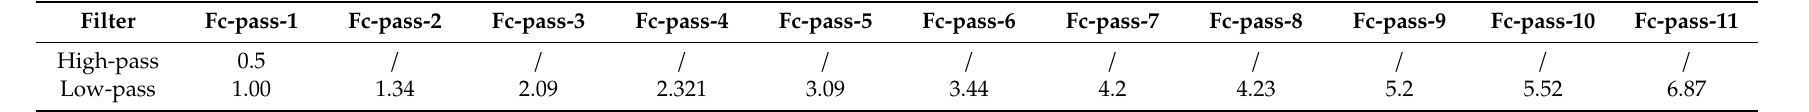
Table 2. Hyper low-pass filtering setup (in Hz). Table 3. Hyper High-pass filtering setup (in Hz).